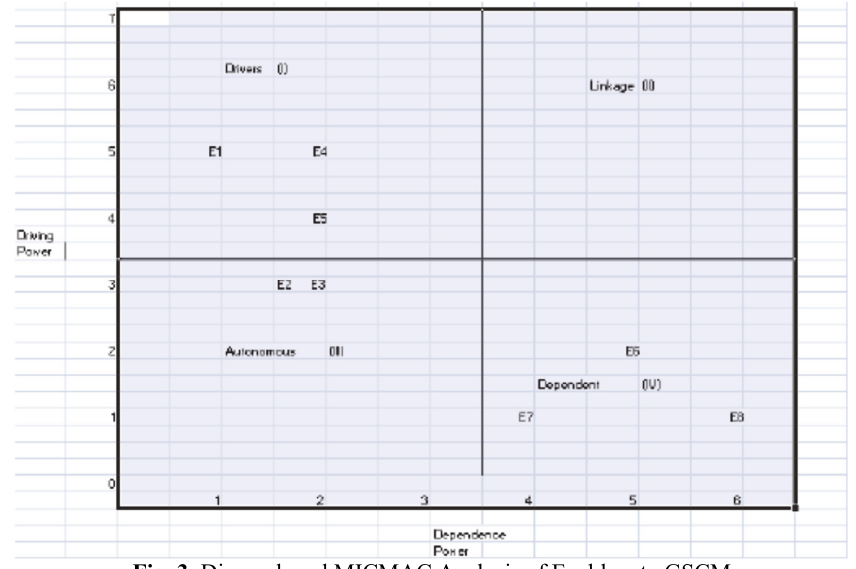
Fig. 3. Diagraph and MICMAC Analysis of Enablers to